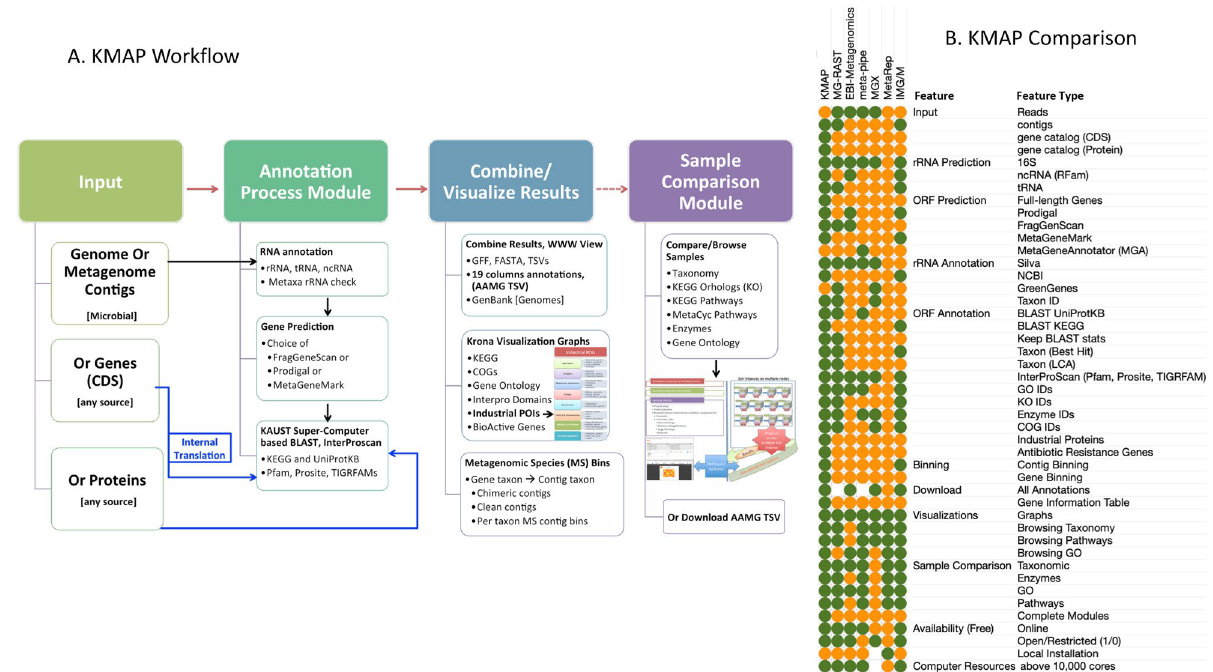
Figure 4. KMAP workflow and Comparative overview of features in KMAP and other most relevant pipelines for metagenomic data analysis. The pipelines included in comparison are MG-RAST 23 , EBI Metagenomics 10 , Meta-Pipe 24 , MGX 25 , MetaRep 21 and IMG/M 26 . A score of 1 is assigned for features present (green color), 0 for absent (orange) and with limited availability a score of 0.5 is assigned